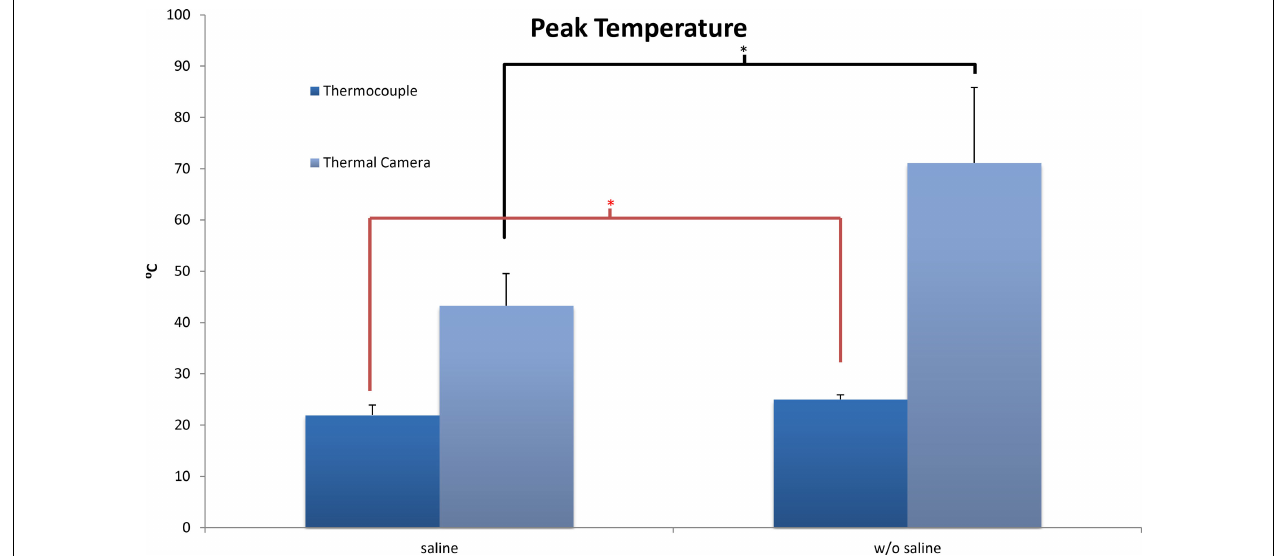
FIGURE 3 | Peak temperatures as recorded by thermocouple and thermal camera systems. * p <<< 0.05